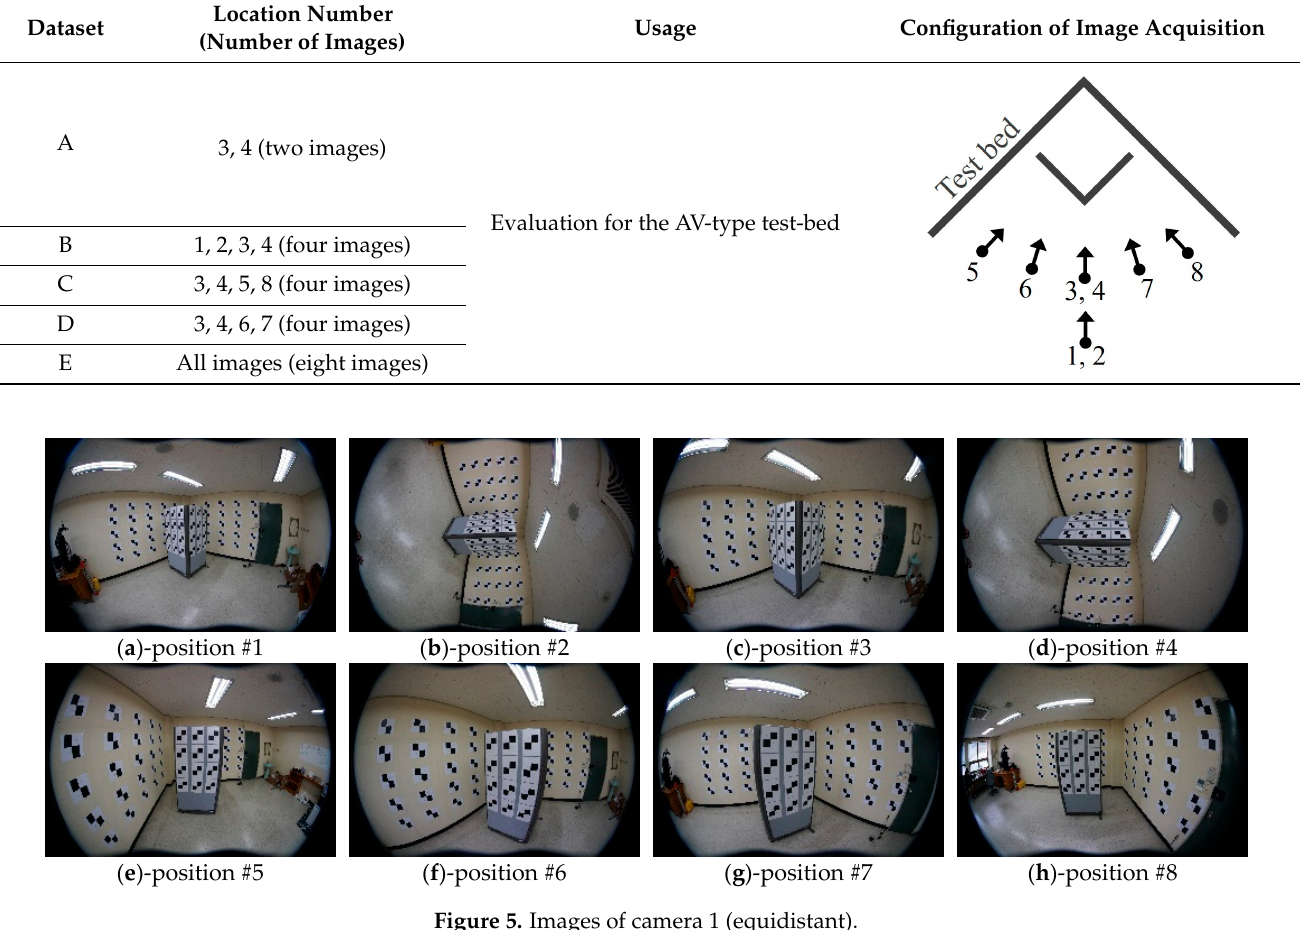
Table 4. Configuration of image acquisition and dataset for real experiments.